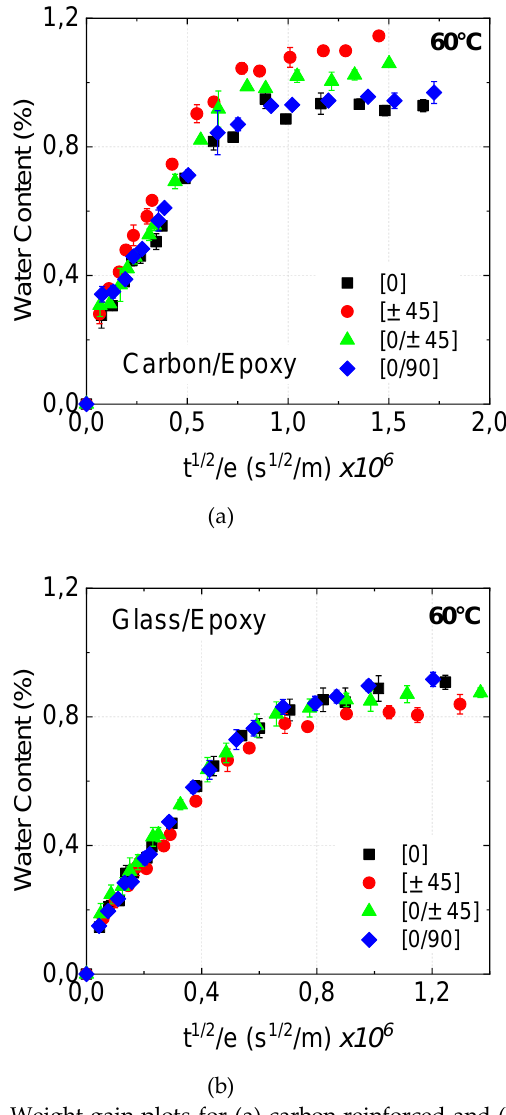
Fig. 1. Weight gain plots for (a) carbon reinforced and (b) glass reinforced epoxy reference composites. (t: time, e: coupon thickness, s: seconds, m: meters) Based on these results, and others at other water temperatures, it was possible to predict the time to saturation of the test specimens with other